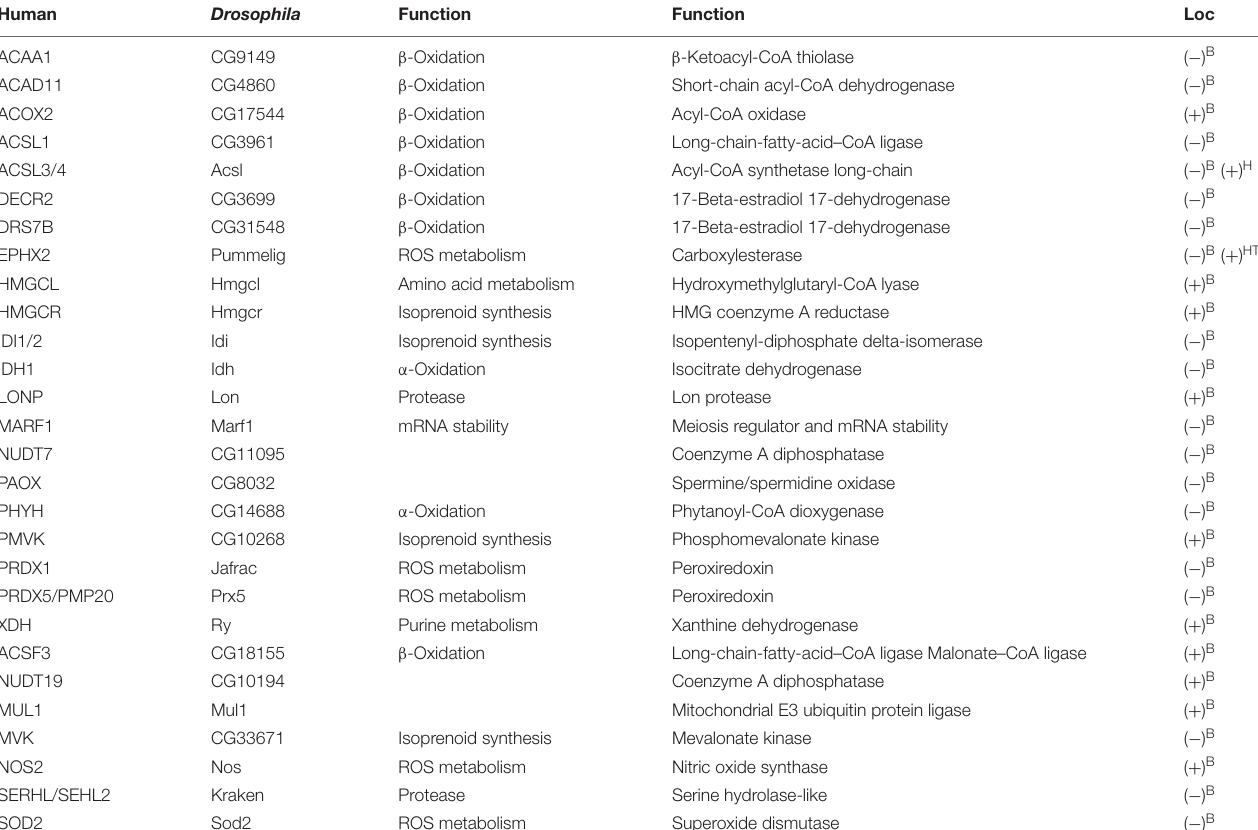
TABLE 4 | Drosophila peroxisome matrix enzymes without a PTS1 motif.